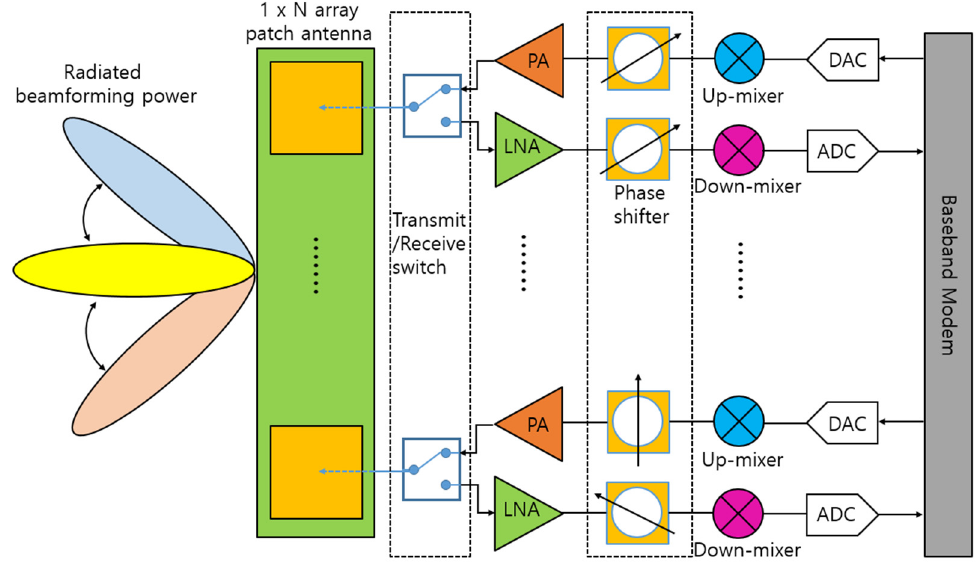
Figure 1. Block diagram of a 5G antenna module.